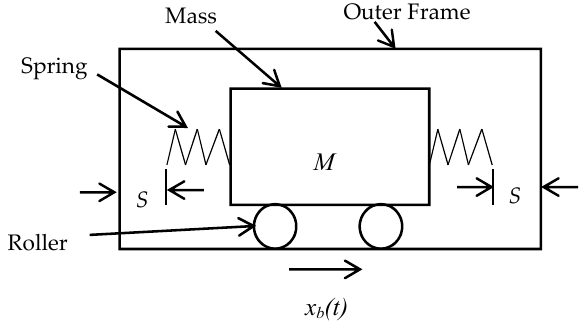
Figure 2. Model of the impact-based kinetic energy harvester.